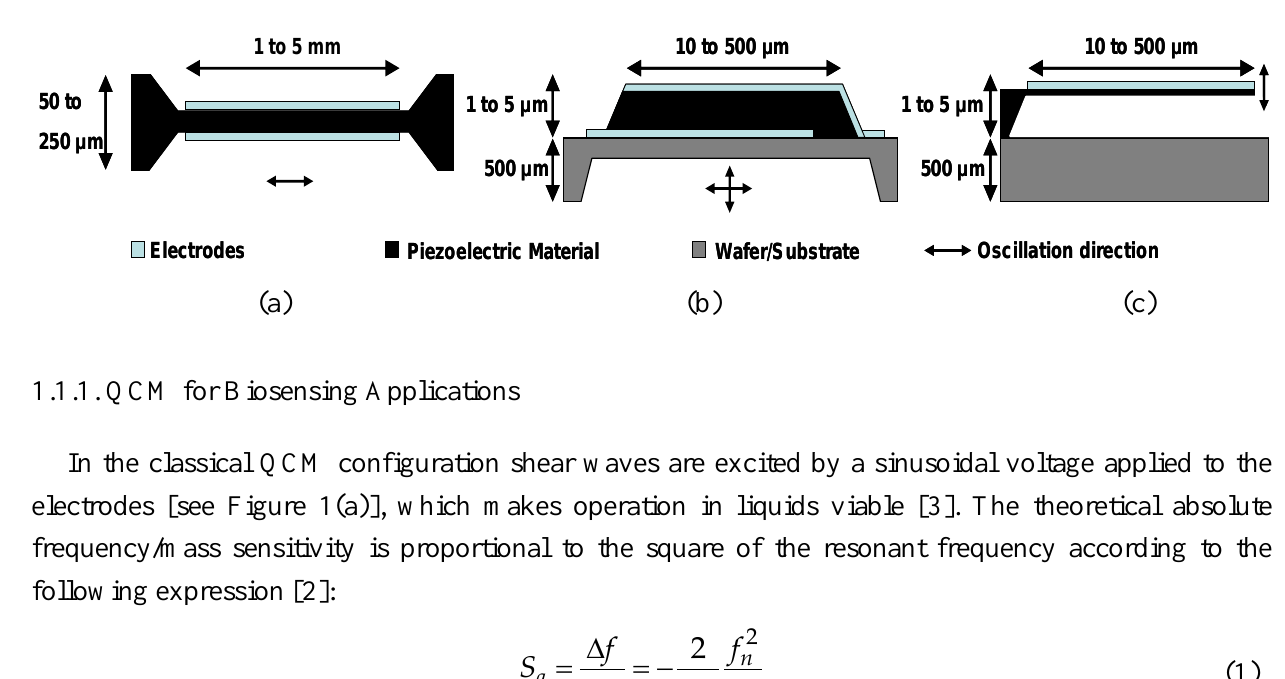
Figure 1. Bulk acoustic devices: (a) QCM, (b) FBAR and (c)